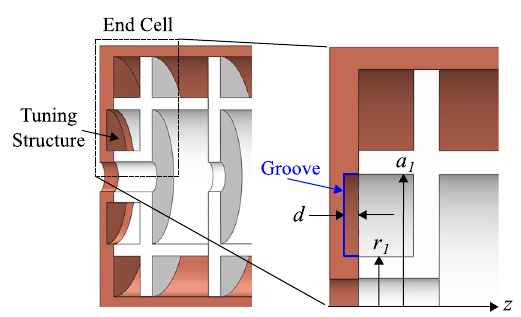
FIG. 4. Normalized longitudinal electric field strengths on the beam axis in the prototype models with d ¼ 0 . 0 mm (blue line) and d ¼ 4 . 0 mm